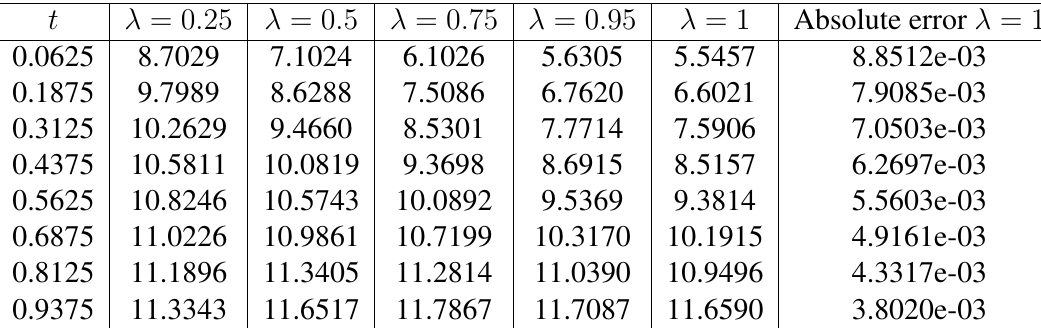
Table 3: The achieved absolute errors and numerical solutions of Example 4.3 using the proposed strategy for J = 2 and T = 1